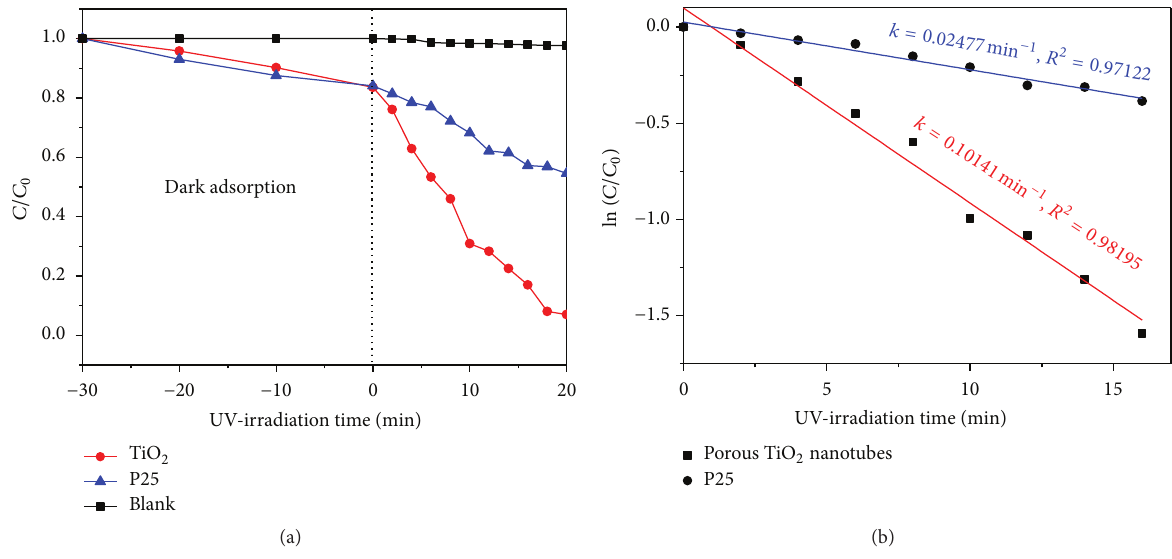
Figure 7: Photodegradation kinetics of methyl orange in the presence of porous TiO 2 nanotubes. (a) Plot for the degradation percentage ( 𝐶/𝐶 0 ) of MO solutions versus time intervals. (b) ln (𝐶/𝐶 0 ) as a function of reaction